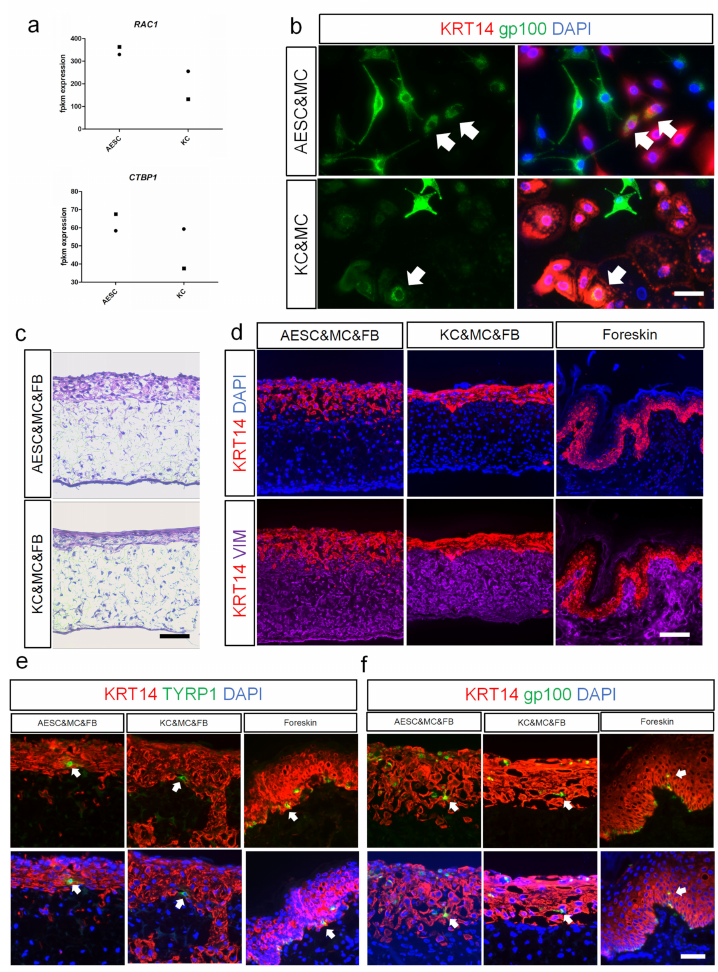
Figure 4. Amniotic epithelial stem cells (AESCs) interact with melanocytes and phagocytose melanosomes. ( a ) RAC1 and CTBP1 expression in AESCs and KCs, observed by RNA sequencing. ( b ) KRT14 (red) and gp100 (green) immunostaining in co-culture systems. Arrows: KRT14 + gp100 + cells. ( c ) Reconstructed 3D skin using human fibroblasts, MCs and AESCs or KCs, respectively. ( d ) KRT14 (red) and VIM (purple) immunostaining in reconstructed 3D skin and normal human skin. ( e ) KRT14 (red) and TYRP1 (green) immunostaining in reconstructed 3D skin and normal human skin; Arrows: KRT14 + TYRP1 + cells. ( f ) KRT14 (red) and gp100 (green) immunostaining in reconstructed 3D skin and normal human skin; Arrows: KRT14 + gp100 + cells. FB, fibroblast; AESC, amnion epithelial stem cell; KC, keratinocyte; MC, melanocyte; Scale bar = 100 µ m ( c , d ); 50 µ m ( b , e , f